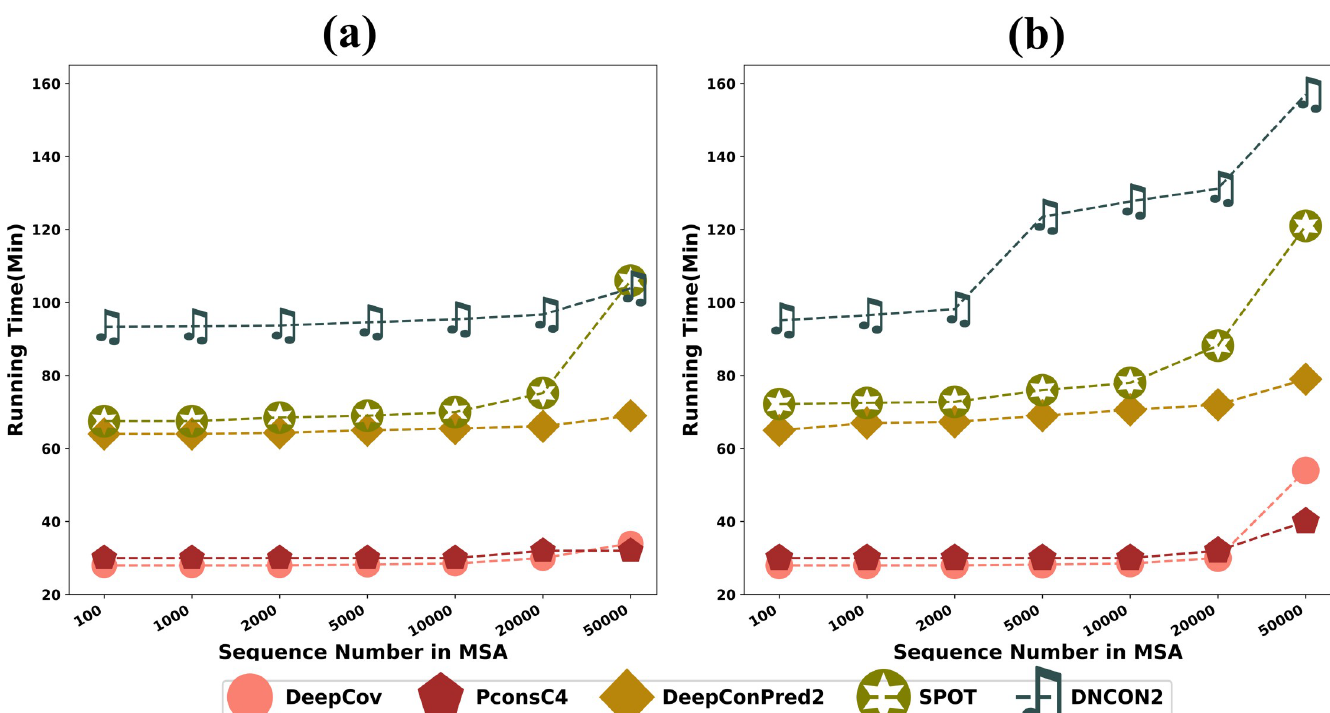
Fig 11. Runtime tests on proteins with (a) ~200 residues and (b) ~500 residues with the variation of the sequence number in the MSA